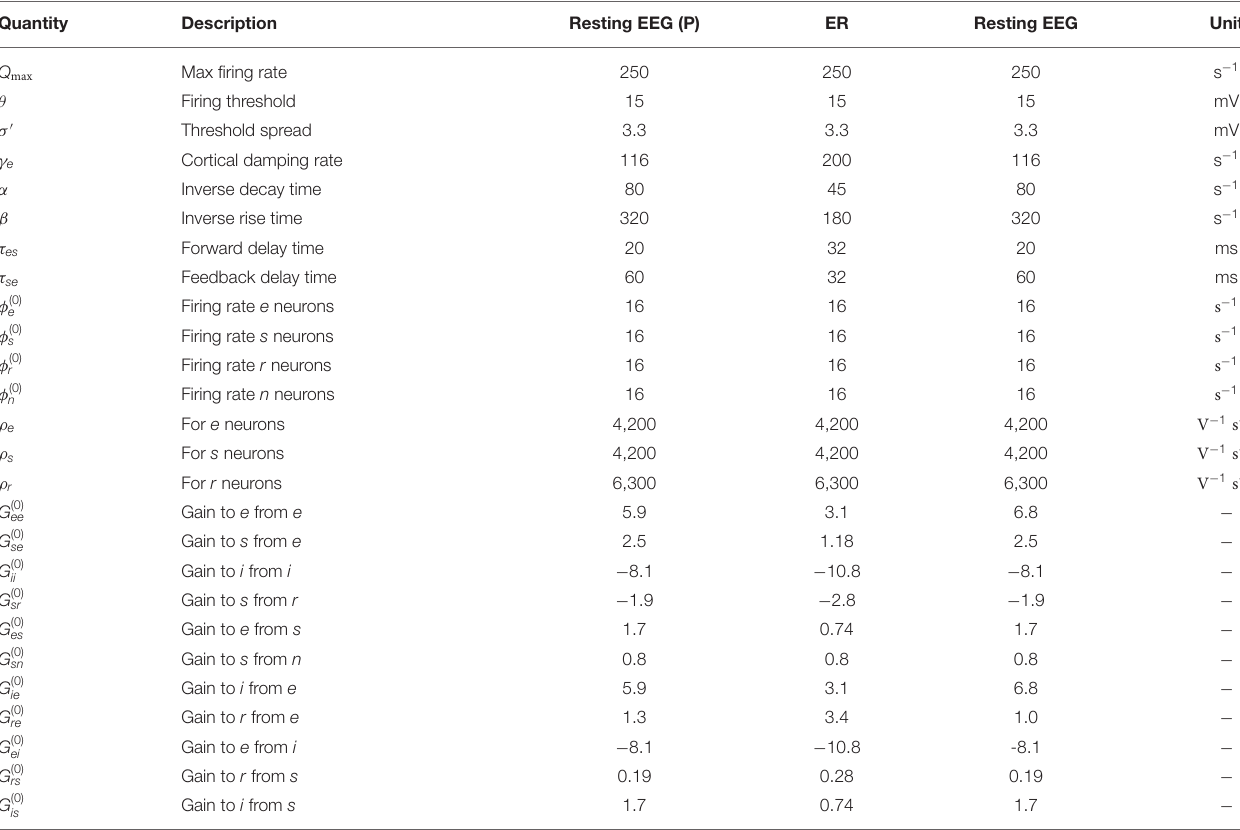
TABLE 1 | Estimated brain parameters for normal adult humans in the alert, eyes-open state.